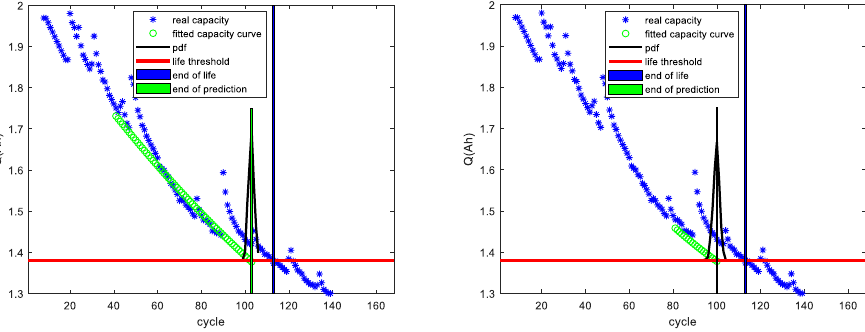
Figure 9. RUL prediction results of the B6 battery using standard